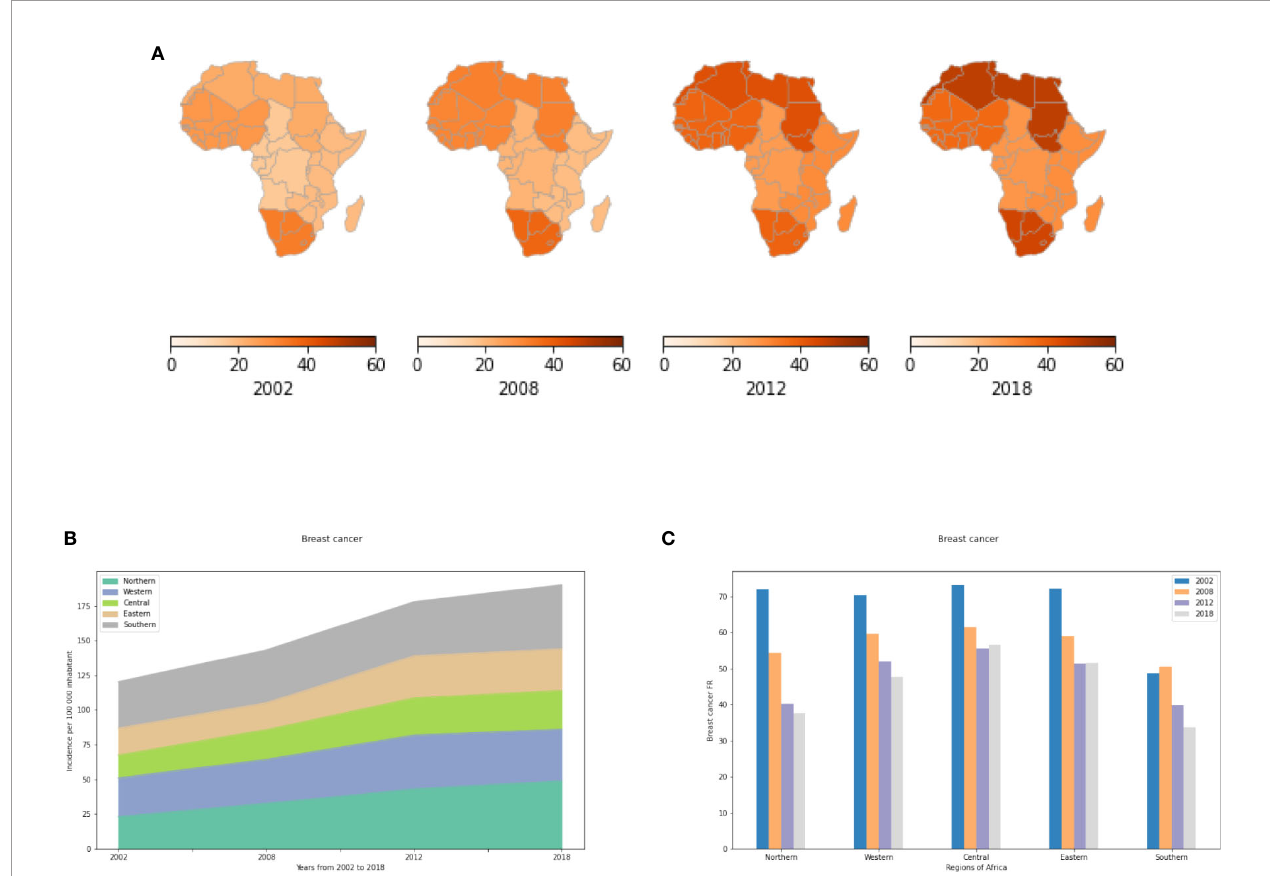
FIGURE 1 | Incidence and fatality rates of breast cancer per 100,000 inhabitants from 2002 to 2018. IR refers to active cancer cases per year and per region per 100 000 inhabitants. The FR of a region per year is obtained by dividing the number of cancer deaths by the total number of active cancer cases per year in a speci fi c region and multiplying by a hundred to give a percent. (A) Breast cancer incidence rates in the different African regions per 100,000. (B) Changes in incidence rate from 2002 to 2018. (C) Breast cancer fatality rates (percent mortality per year of those af fl icted) in the different African regions given as a